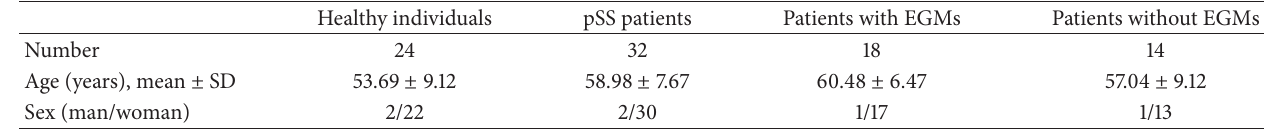
Table 1: The demographic characteristics of subjects enrolled in the